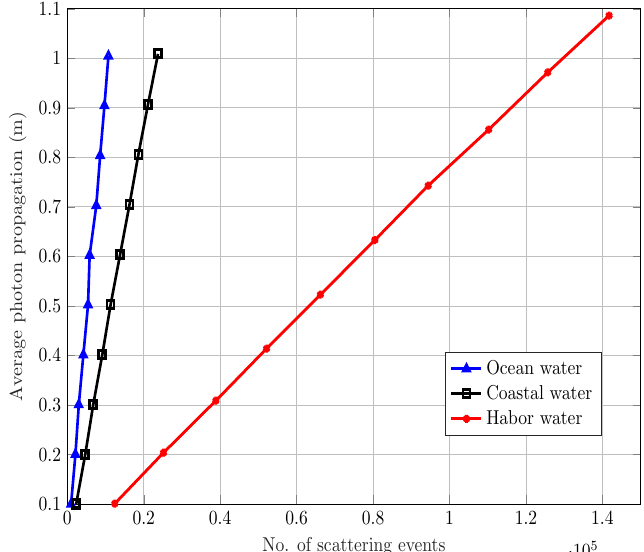
Figure 11. Average distance traveled by photon versus no. of scattering